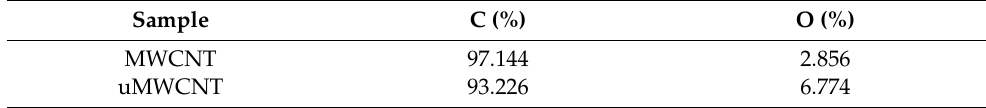
Table 1. Elemental analysis of MWCNTs and uMWCNTs.